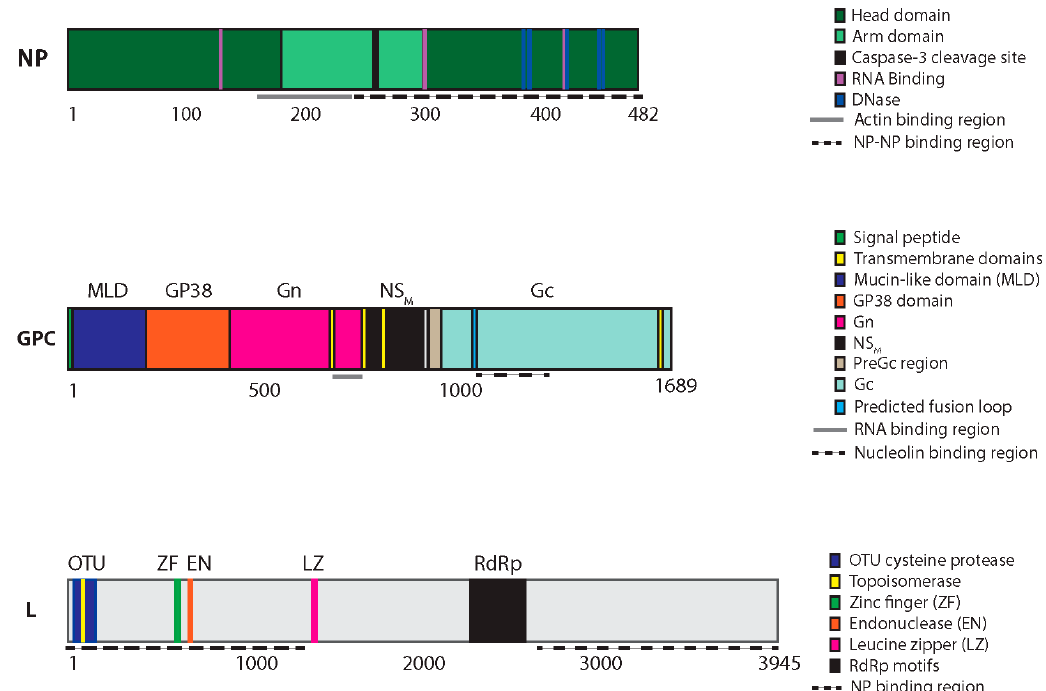
Figure 4. CCHFV protein domains, motifs and catalytic residues. The three CCHFV genomic segments (S, M and L) are translated into three proteins: NP, the GPC, and the L protein, respectively. The GPC is proteolytically processed to yield several additional proteins, including Gn and Gc. The approximate total size and location of motifs and catalytic residues of each protein is indicated below in amino acids.